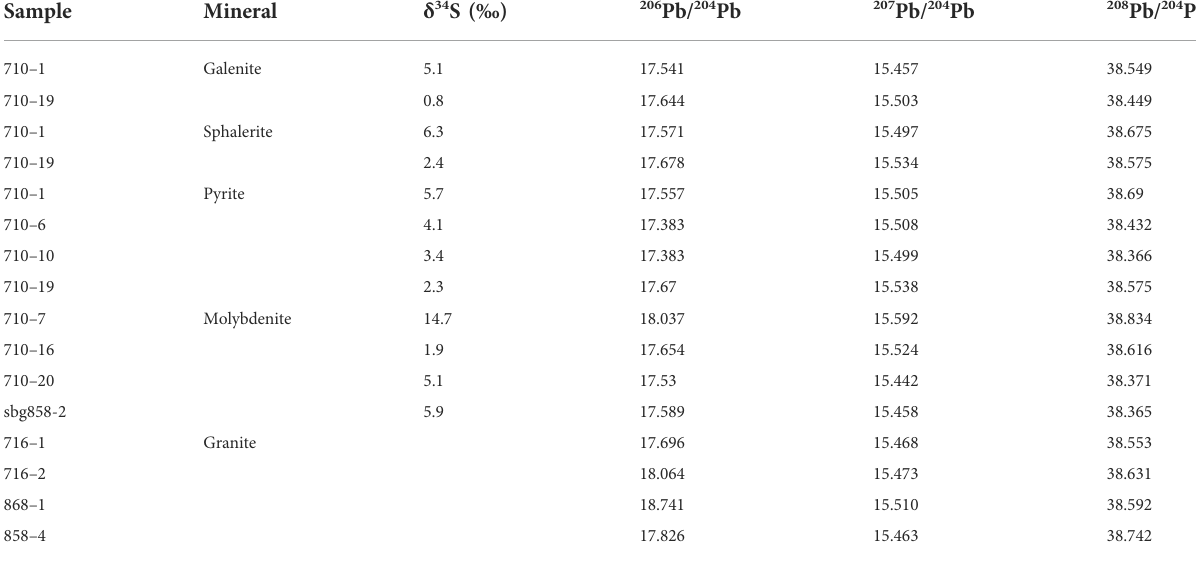
TABLE 4 Pb isotope data and S isotope composition of sul fi des from the Shibaogou